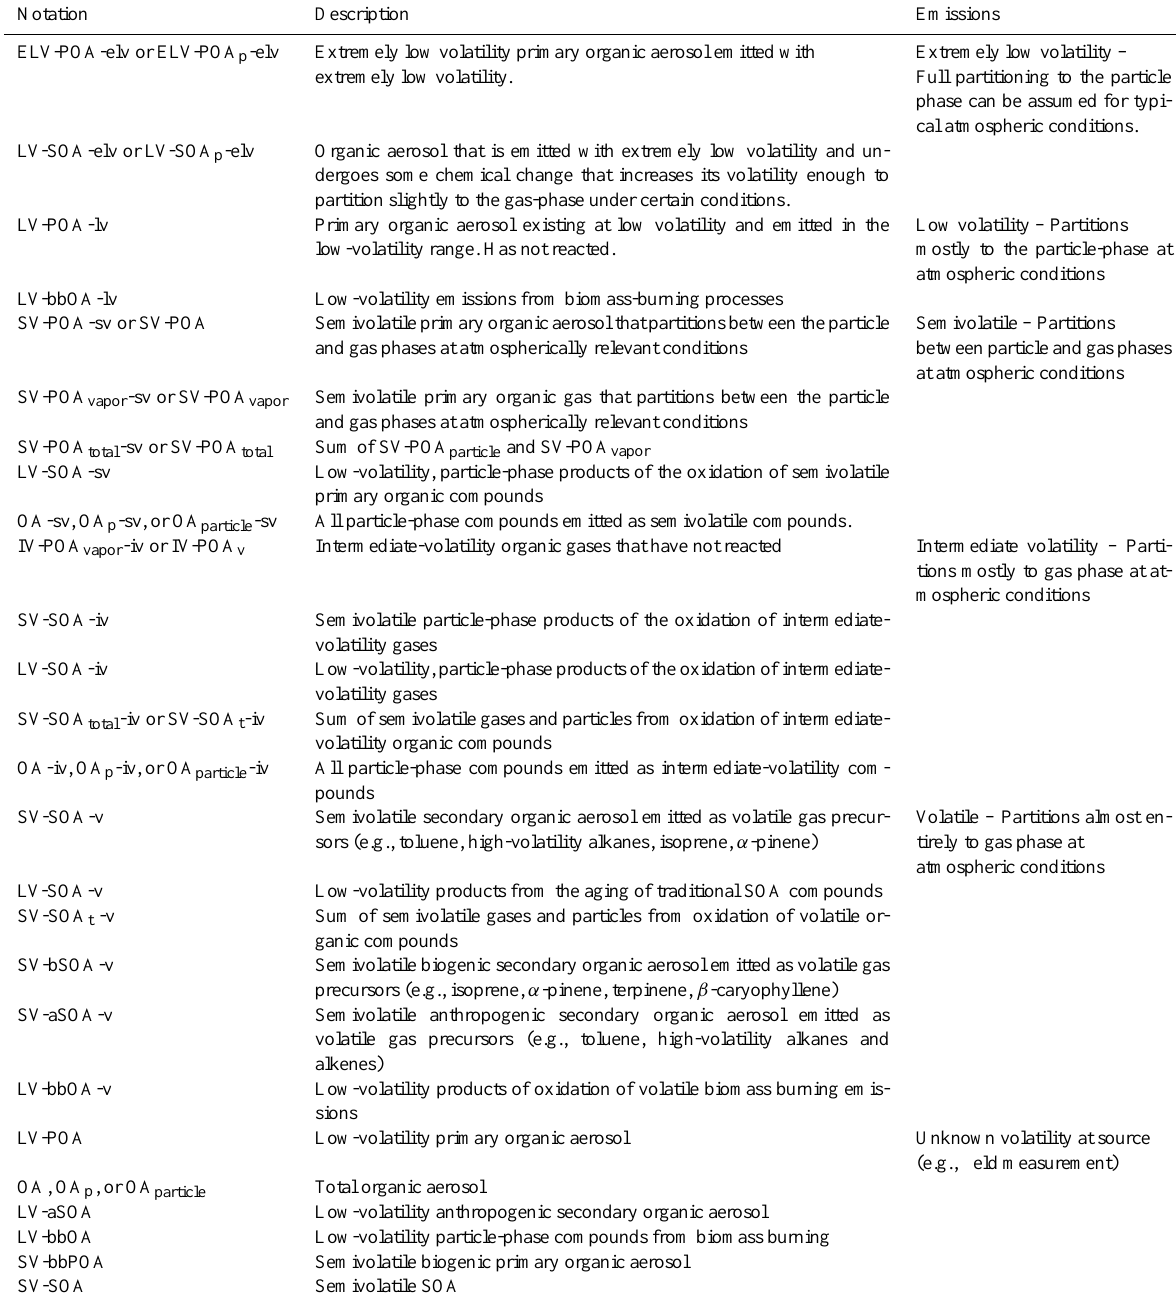
Table 5. Examples of organic aerosol classifications under the proposed naming